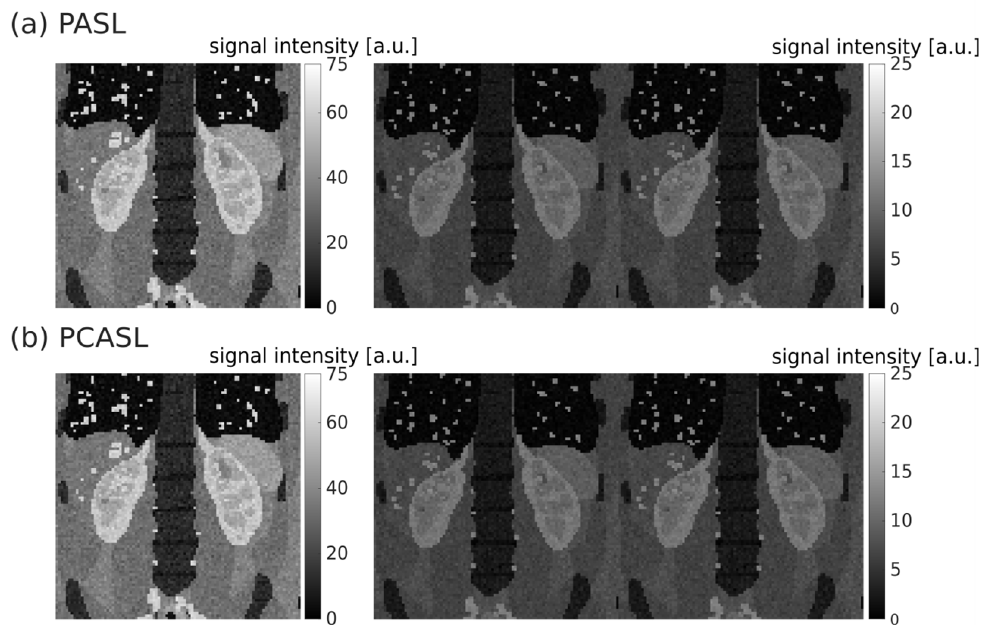
Figure 1. Exemplary PASL ( a ) and PCASL ( b ) single-slice data sets (model 77). Left column: M0 images; middle column: first control images; right column: first labeled images. The signal intensity of control and labeled images is lower than that of the M0 due to background suppression.